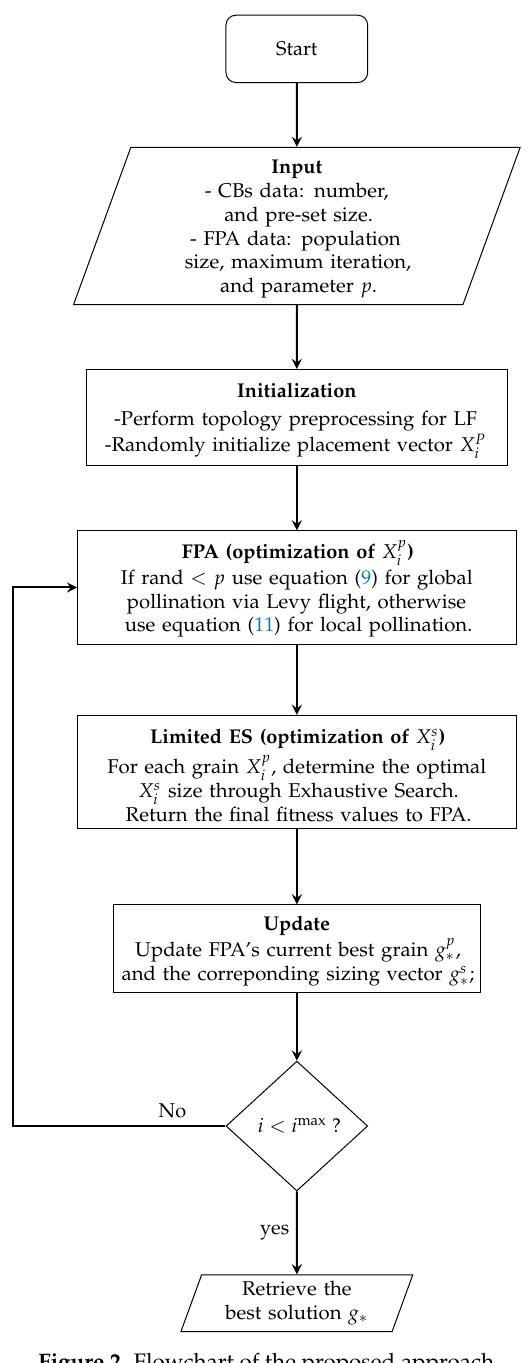
Figure 2. Flowchart of the proposed